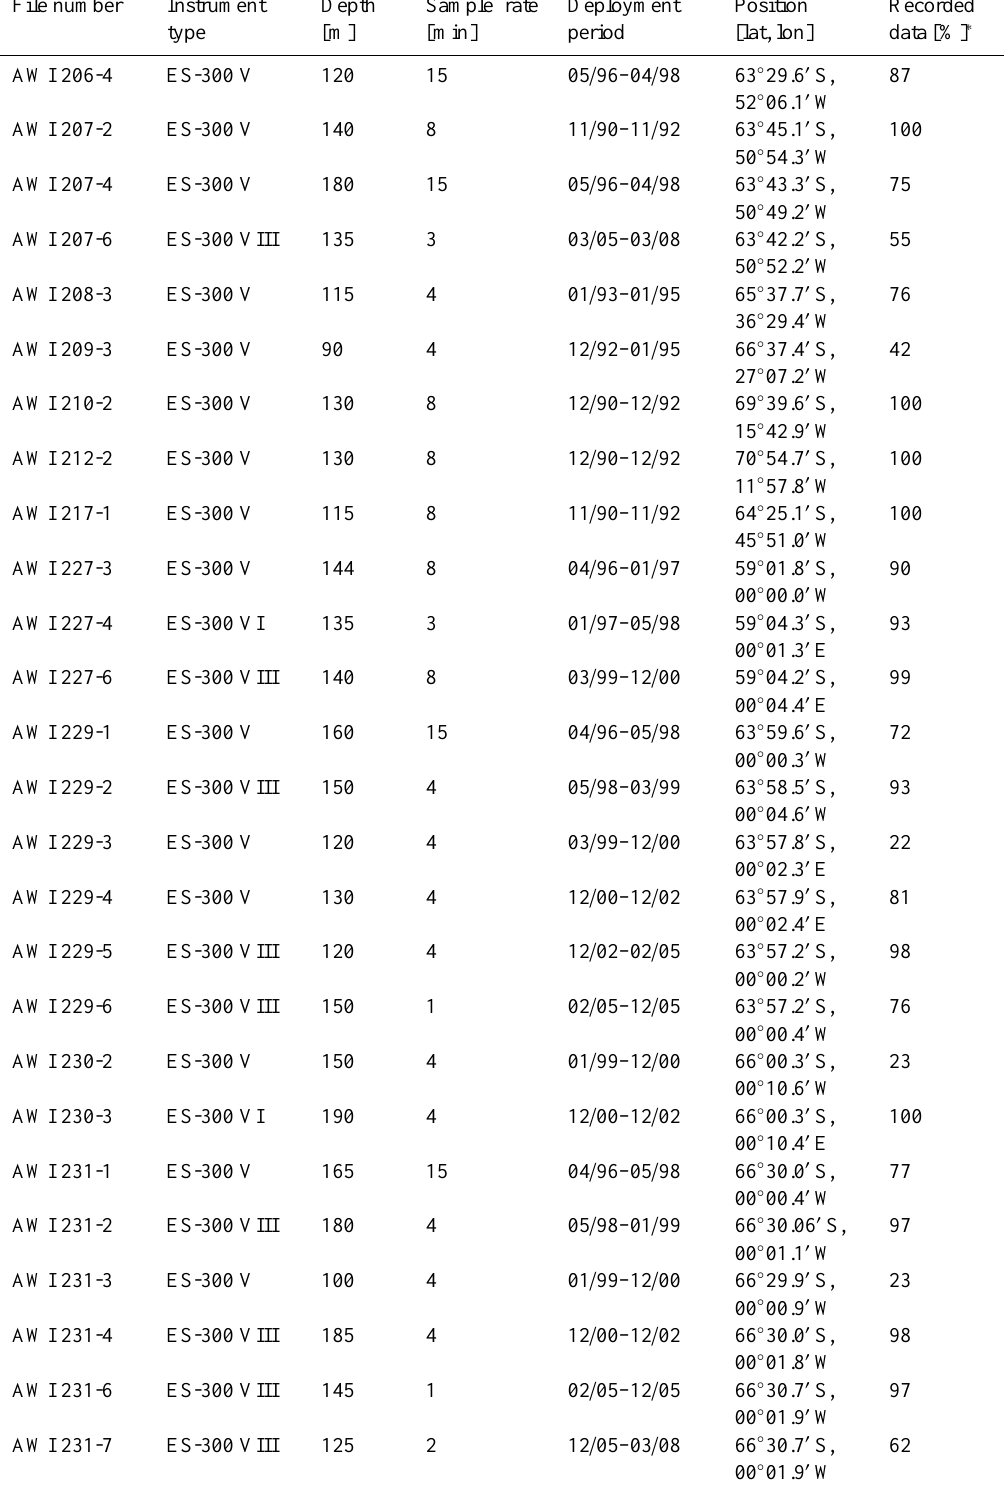
Table 5. Available ULS